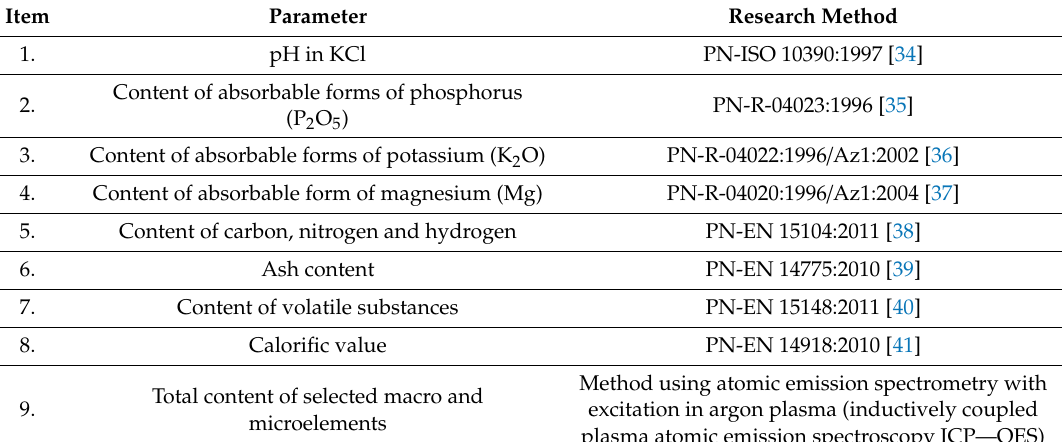
Table 1. Parameters analysed with research methods.